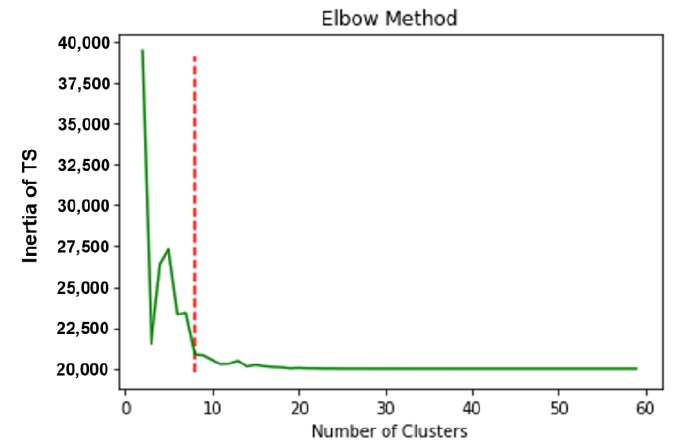
Figure 5. Result of elbow method to set k.